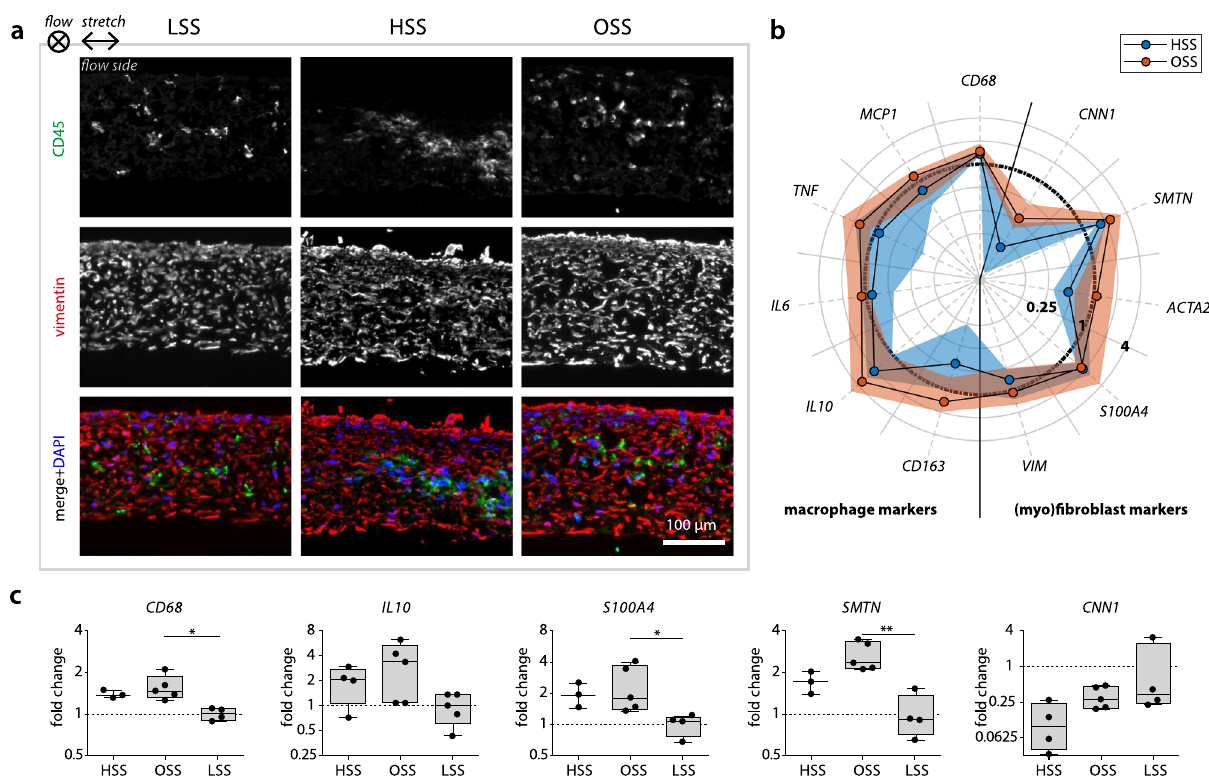
Fig. 5 Phenotypical characterization of the cells in the vascular constructs at day 14. a Representative cross-sections for each experimental group stained for CD45 (green) and vimentin (red) for the localization of macrophages and (myo) fi broblasts, respectively (nuclei are indicated in the lower panel in blue). b Relative gene expression compared to the low shear stress condition (indicated by the circle at 1) for macrophage-related genes (left part of the polar plot) and (myo) fi broblast-related genes (right part of the polar plot, n ≥ 3/group). The dots and shaded areas indicate, respectively, the 50 th and 25 th – 75 th percentiles. c Boxplots for a selection of phenotypical-related genes ( n = 3, 4, or 5, * p < 0.05, ** p < 0.01). Boxplots contain 50% of the data with median highlighted by central mark. HSS high shear stress condition (3.2 Pa), OSS oscillatory shear stress condition (±3.2 Pa), LSS low shear stress condition (0.4 Pa). See Supplementary Fig. S1 for all boxplots of the gene expression